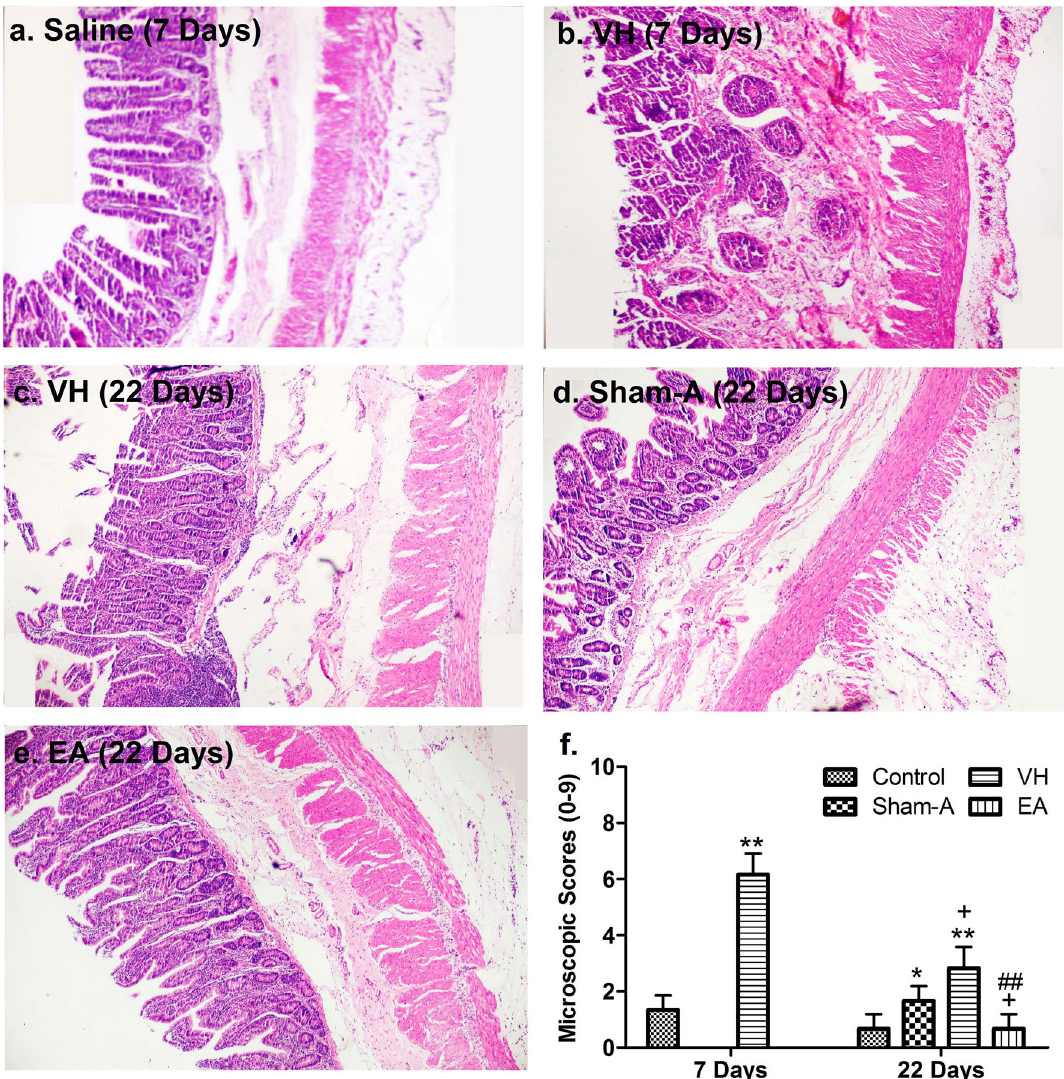
Figure 2. Effects of TNBS administration and EA stimulations on microscopic pathological changes in the ileum of goats (Mean ± SD, n = 6). Microscopic changes in the distal ileal section stained with hematoxylin and eosin (H&E) at days 7 and 22. Representative images (20×) were taken from Control and VH group on day 7 and from VH, Sham-A and EA groups on day 22 ( a – e ). The microscopic changes were assessed and scored by two pathologists unawared with the treatment status on a 0–9 scale, i.e., crypt architecture (0–3), inflammatory cells infiltration (0–3), and ulceration (0–3) ( f ). A Kruskal–Wallis H test showed a significant difference in microscopic scores between the Control and VH group, χ 2 (2) = 8.800, P = 0.003, df = 1 with a mean rank microscopic scores of 3.50 and 9.50, respectively at 7 days. A Mann–Whitney U-test indicated that the microscopic scores of VH group increased ( P = 0.003) significantly than Control group on day 7. Microscopic scores [ χ 2 = 17.436, P = 0.001, df = 3 with a mean rank microscopic scores of 7.17 for Control, 14.83 for Sham-A, 20.83 for VH and 7.17 for EA group] at 22 days. Microscopic scores were remarkably increased in the VH group ( P = 0.003) and Sham-A group ( P = 0.014) than the Control group. However, the EA group resulted in significantly lower microscopic scores than those of Sham-A ( P = 0.014) and VH group ( P = 0.003) on day 22. ** P < 0.01; * P < 0.05, VH/Sham-A group versus Control group; + P < 0.05, VH/EA group versus Sham-A group; ## P < 0.01, VH group versus EA with 80–100 mmHg [F(3,20) = 81.642 with 80 mmHg and 78.592 with 100 mmHg, P = 0.001] CRD pressures on day 10, with 40–100 mmHg CRD pressures [F(3,20) = 27.221 with 40 mmHg, 30.568 with 60 mmHg, 26.191 with 80 mmHg, 45.258 with 100 mmHg; P = 0.000] on day 13, and with all CRD pressures [F(3, 20) = 12.102, 49.825 and19.969 for days 16, 19 and 22, P = 0.000 with 20 mmHg; F(3,20) = 48.858, 67.556 and 34.565 for days 16, 19 and 22, P = 0.000 with 40 mmHg; F(3, 20) = 51.912, 52.756 and 26.582 for days 16, 19 and 22, P = 0.000 with 60 mmHg; F(3, 20) = 48.742, 37.975 and 24.473 for days 16, 19 and 22, P = 0.000 with 80 mmHg; 46.739, 42.061, 37.984 for days 16, 19 and 22, P = 0.000 with 100 mmHg) at days 16–22 as compared to the goats of Sham-A or